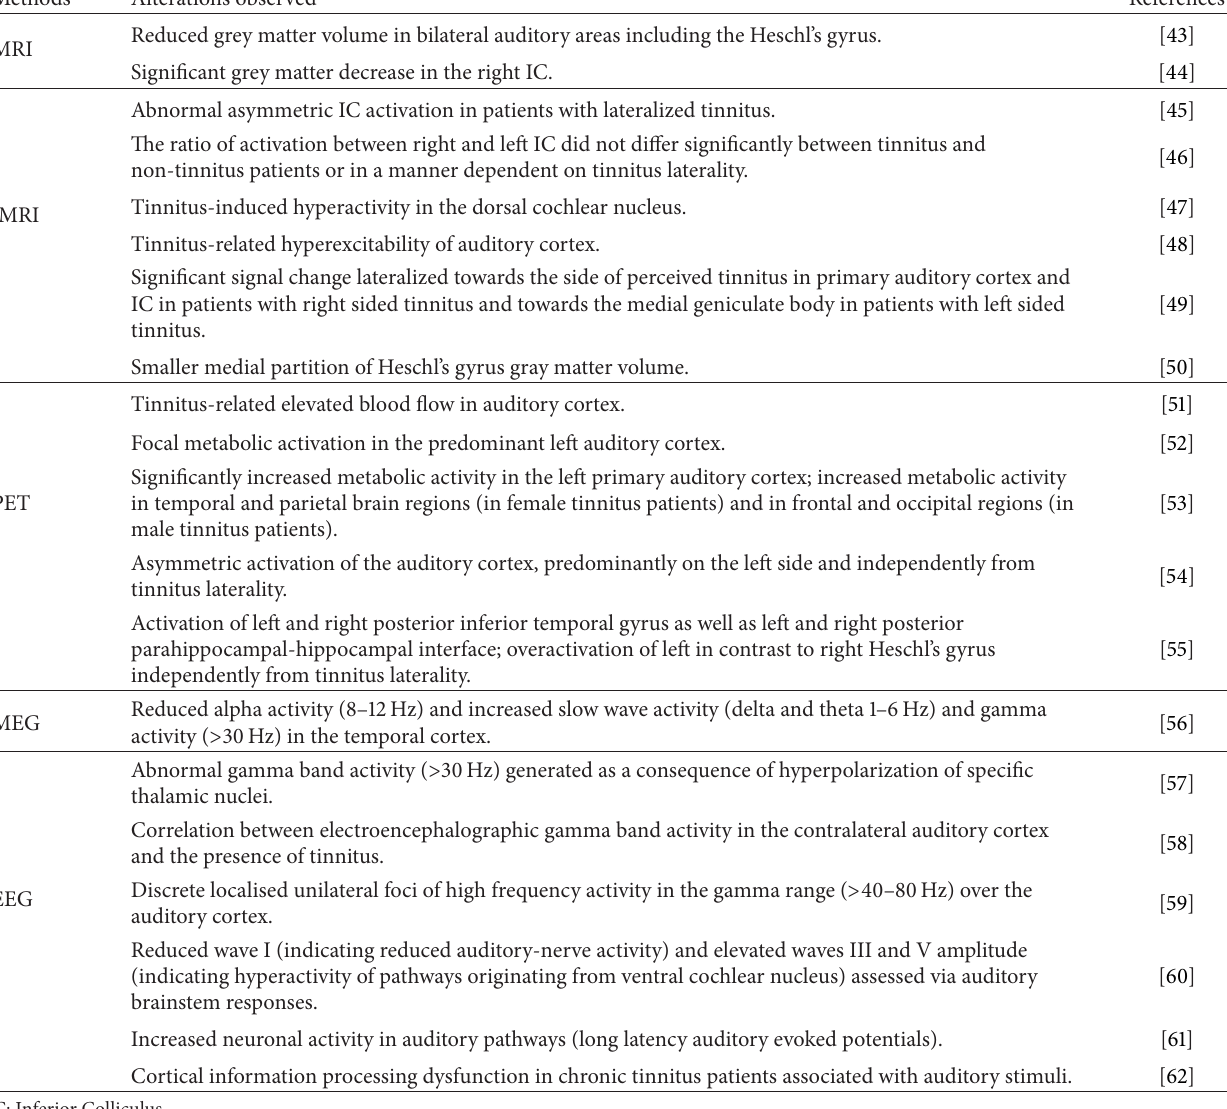
Table 2: Tinnitus-related alterations “into” and “within” auditory